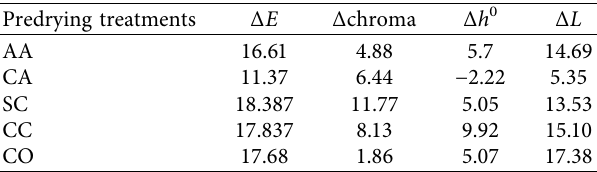
Table 3: Change in color values of dried tomato slices pretreated with different predrying treatments. Predrying treatments